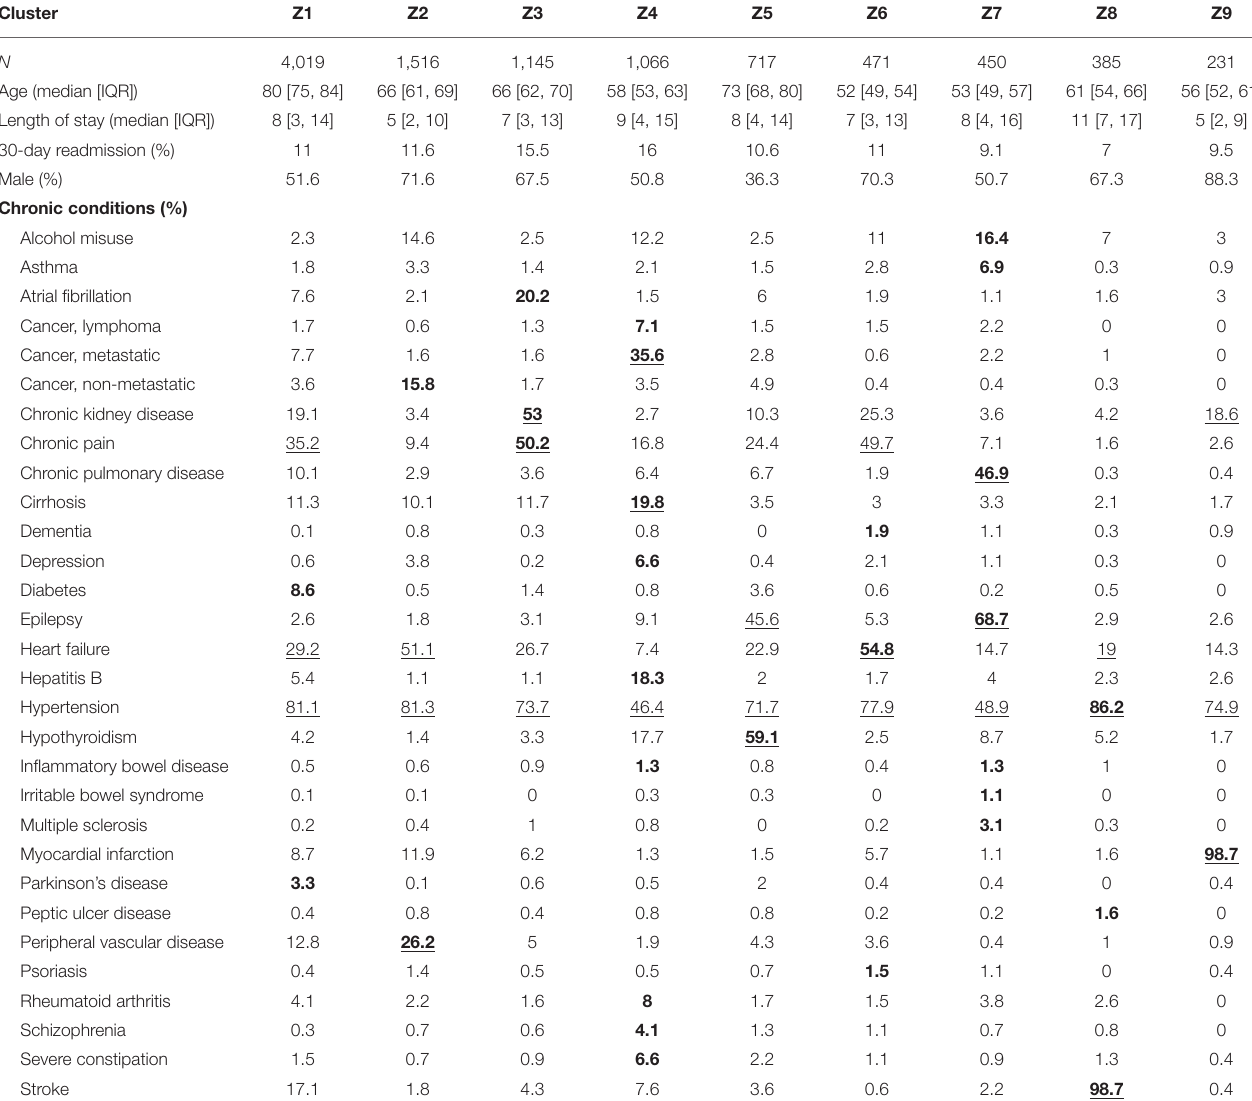
TABLE 3 | Prevalence of chronic conditions by cluster (Zurich)*.